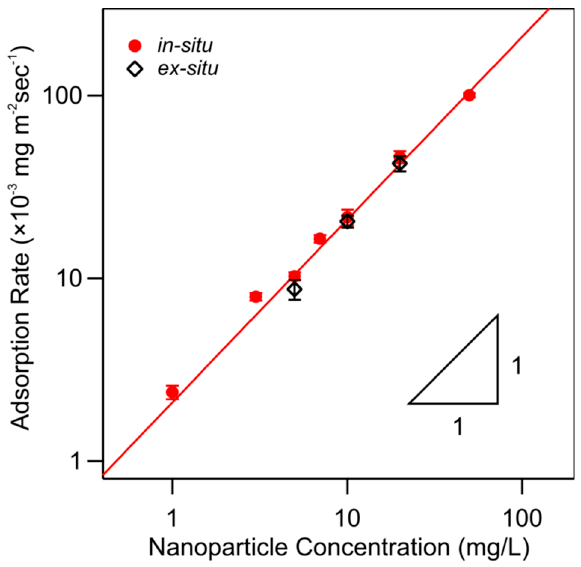
Figure 9. Comparison of the initial nanoparticle deposition rate on PDADMAC-functionalized silica prepared by the in situ and ex situ techniques versus the nanoparticle concentration at pH 4.0 and an ionic strength of 10 mM. The solid line reflects first-order kinetics with respect to the solution concentration. Full and open symbols refer to in situ and ex situ functionalized substrates, respectively.